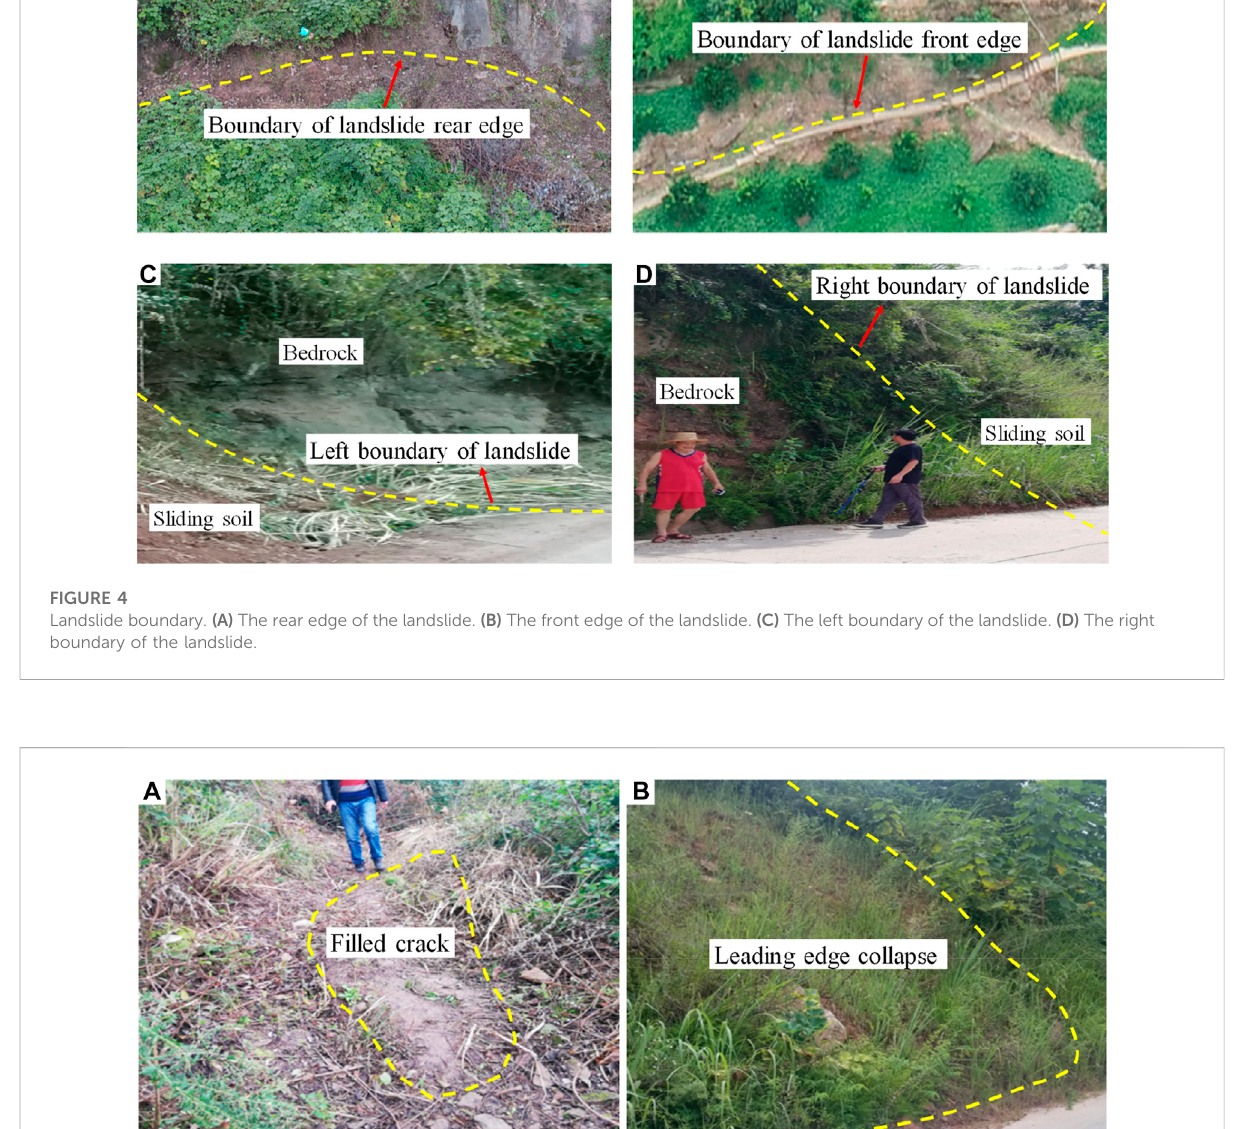
Deformation characteristics of landslide. (A) Trailing edge crack. (B) The local collapse in the